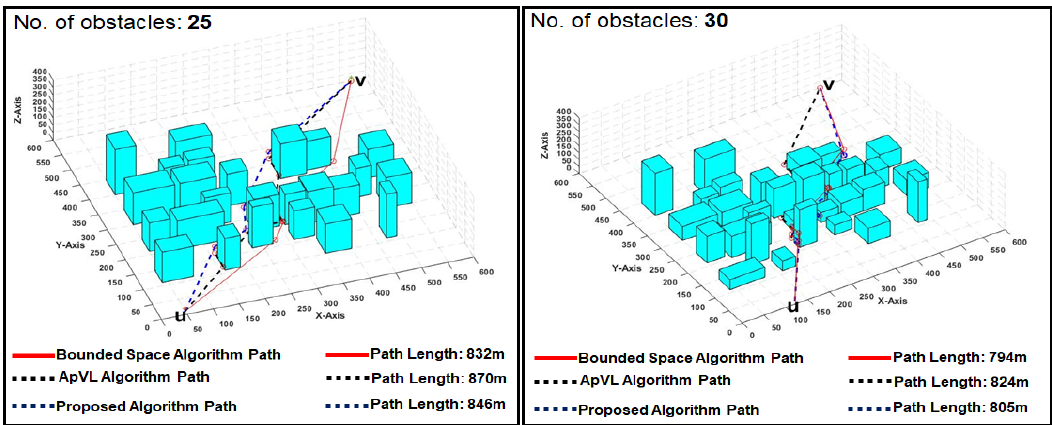
Figure 6. Examples of three different paths generated by each algorithm from the same 3D